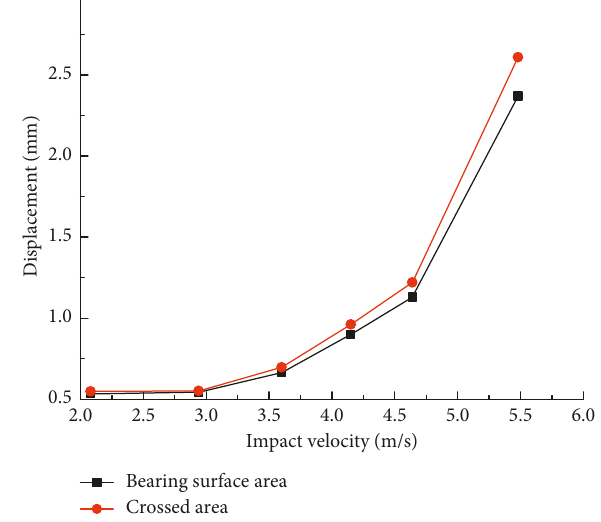
Figure 7: Displacement of impact surface at different impact